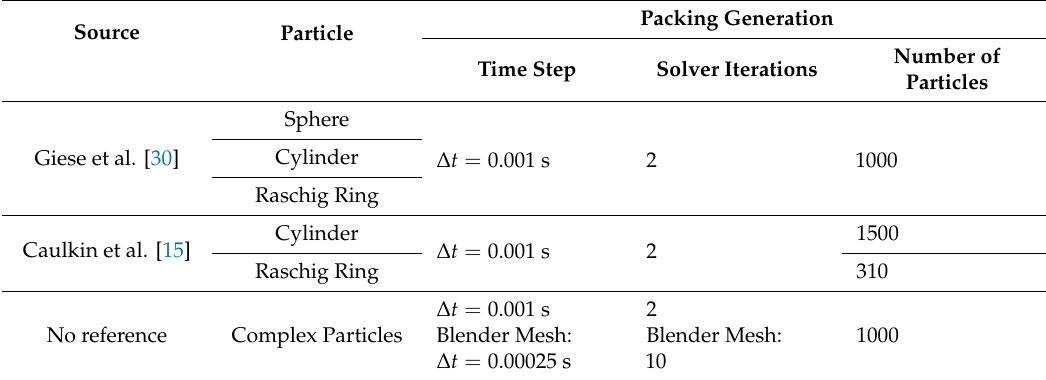
Table 5. Solver Settings for packing generation.